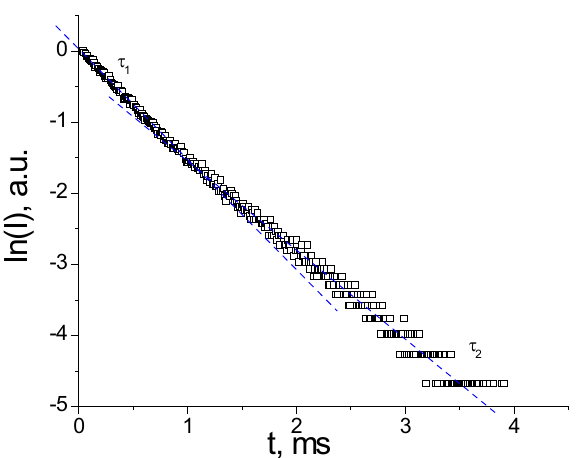
Figure 12. PL decay profile in powder sample at 300 K measured at 612 nm under pulsed excitation at 337 nm.